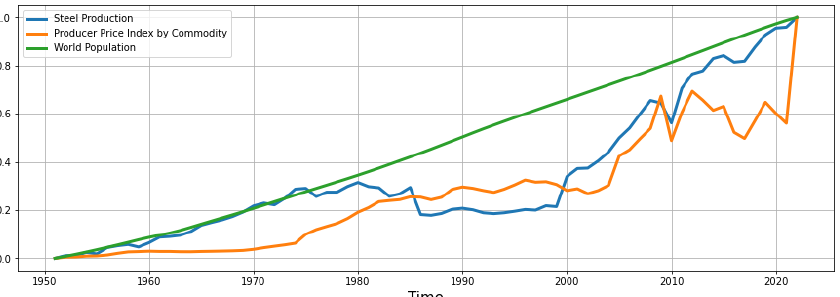
Figure 11. Predictions of the best forecast models based on CNNLSTM and MLP models, with and without the convolutional layer. The blue line is the actual value. The orange line is the prediction based on the training set, and the gray line is the prediction based on the test set. The predictions were obtained with window width 4 and gap 1.